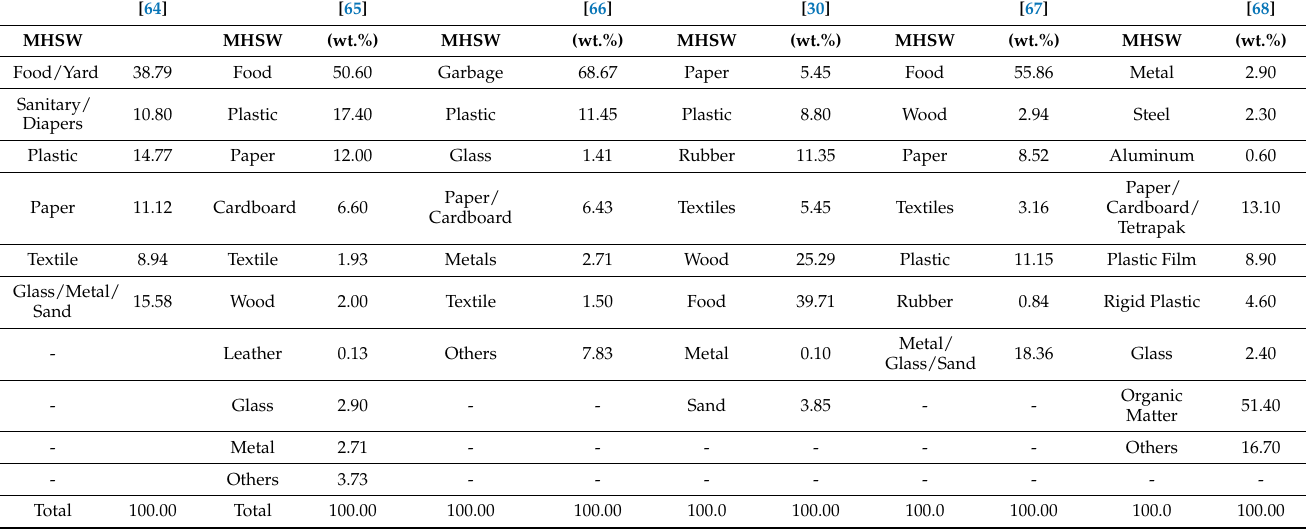
Table 6. Gravimetric analysis of Municipal Household Solid Waste (MHSW) reported in the literature [30,64–68], and percentage of class of materials (metal, steel, aluminum, glass, sand, plastic films + rigid